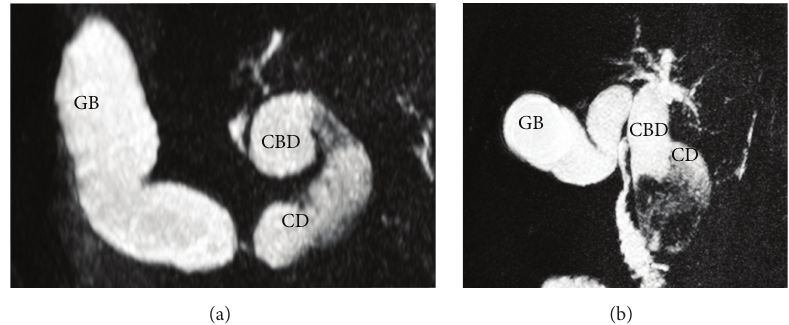
Figure 1: A 58-year-old female with type VI biliary cyst and associated cholangiocarcinoma. (a, b) Axial and coronal MRCP images show fusiformly dilated cystic duct (CD) with a wide opening to the common bile duct (CBD) which is also fusiformly dilated. Intrahepatic bile ducts are slightly dilated in the centre. There is a hypointense, heterogeneous mass filling distal parts of both the cystic and choledochal ducts (GB: gallbladder).